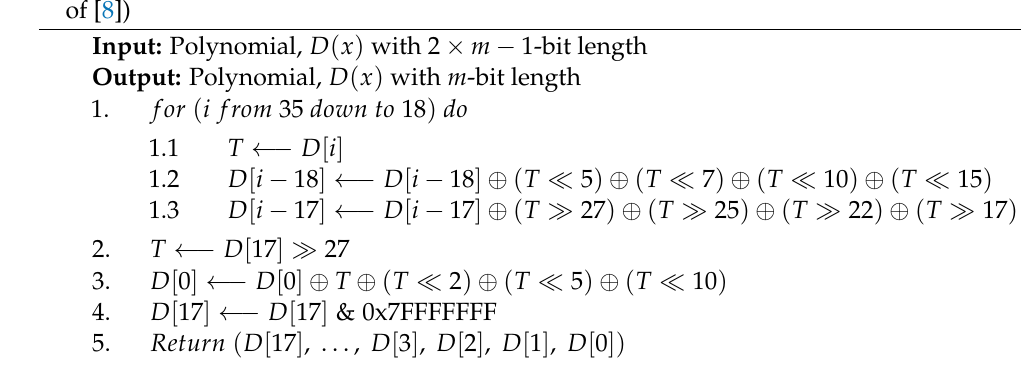
Algorithm A5: Polynomial Reduction Algorithm over GF ( 2 571 ) (algorithm